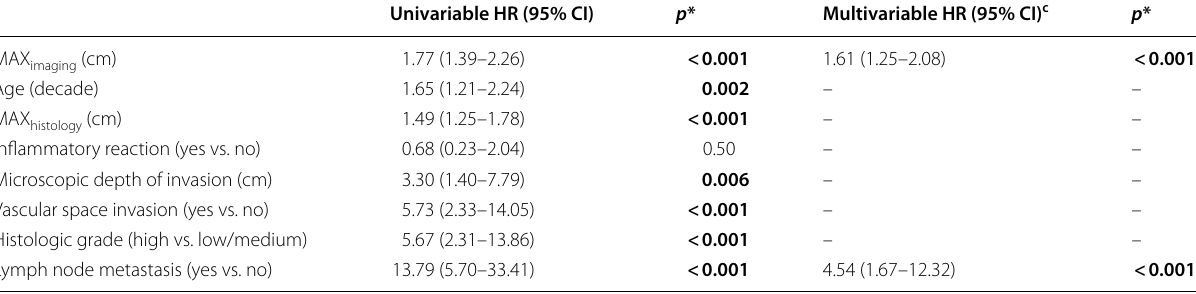
tional file 2: Table S3).